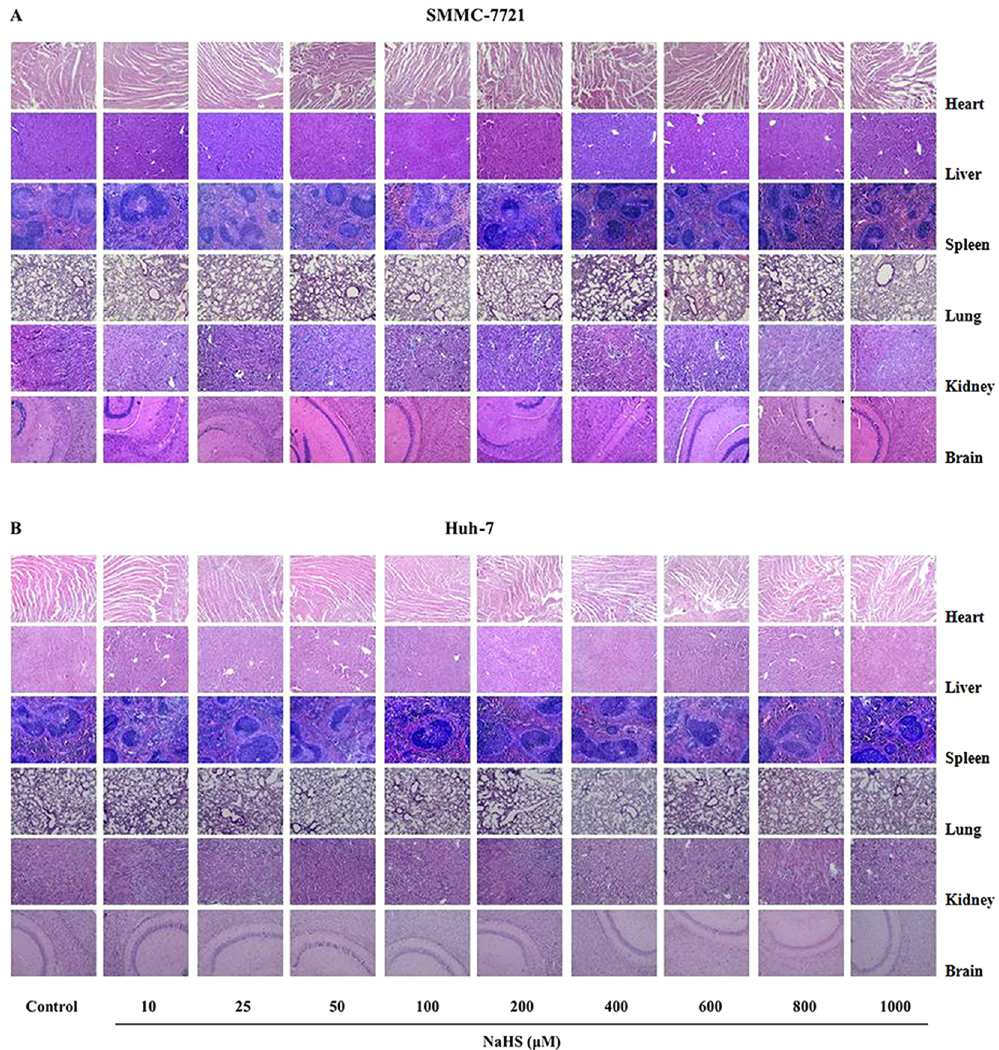
Figure 10. Effect of H 2 S on the structures of the heart, liver, spleen, lung, kidney, and brain in mice. Histopathology of the above-mentioned organs of the mice bearing SMMC-7721 ( A ) and Huh-7 ( B ) xenografts after treatment with NaHS at the indicated concentrations for 14 days. No significant morphological damage was observed. HE staining; original magnification